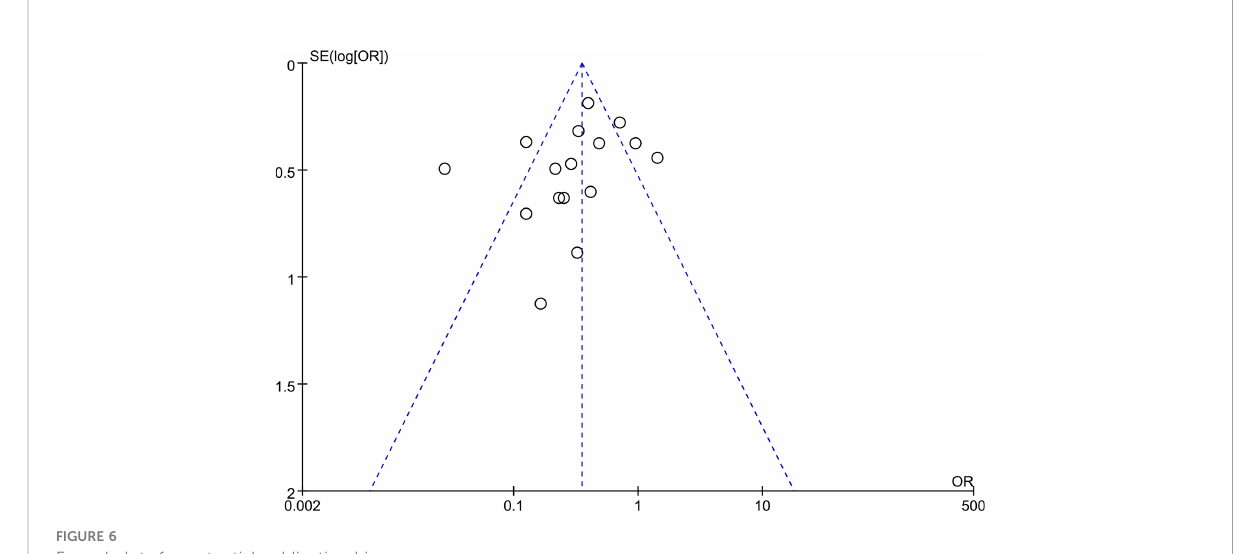
FIGURE 6 Funnel plots for potential publication